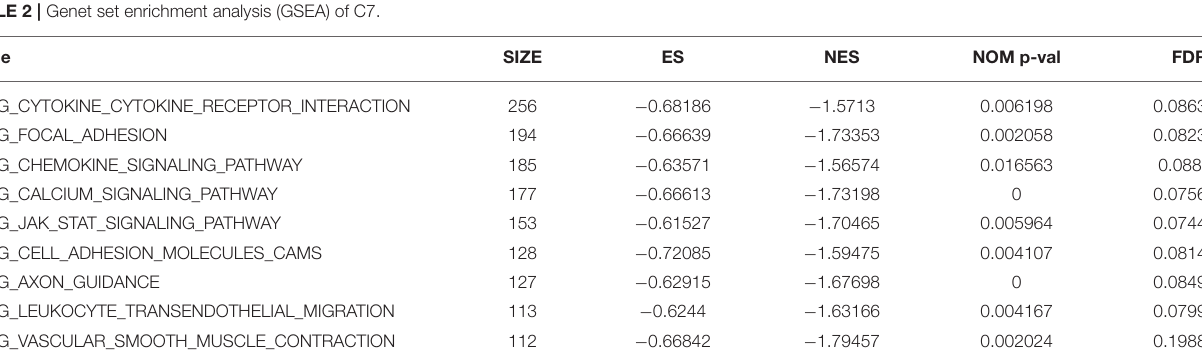
TABLE 2 | Genet set enrichment analysis (GSEA) of